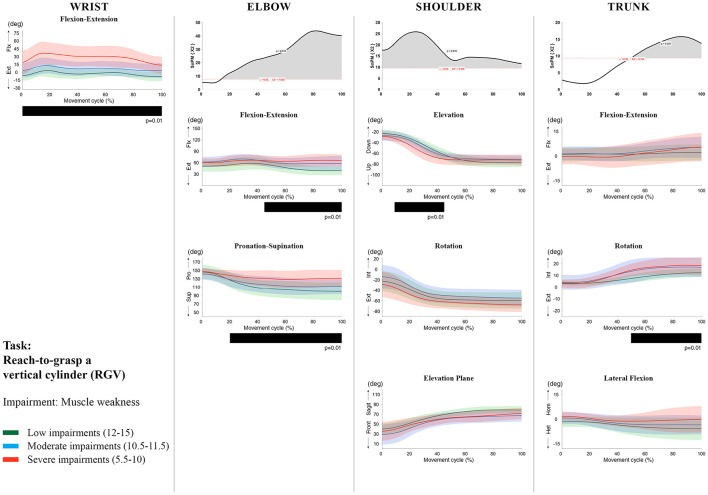
Impact of muscle weakness on UL movement patterns in children with uCP during the RGV task for all joint angles. Each column corresponds to a joint (from left to right: wrist, elbow, shoulder, and trunk). The top image of each column is the SPM output of the vector field analysis (non-parametric Canonical Correlation Analysis test, except for the wrist, where a non-parametric linear regression was computed). For visualization purposes, kinematic data was grouped according to the level of motor impairments, i.e., muscle weakness total score: low impairments (score between 12 and 15, i.e., values above percentile 75), moderate impairments (score between 10.5 and 11.5, i.e., values between percentile 25 and 75), and severe impairments (score between 5.5 and 10, i.e., values below percentile 25). Below, mean (bold line) and standard deviation (translucent area) of the low impairments (green), moderate impairments (blue), and severe impairments (red) of each vector component and the respective post-hoc SPM{t} output. The black bar under each kinematic profile indicates clusters of significant influence of the impairment level on the kinematic variable.